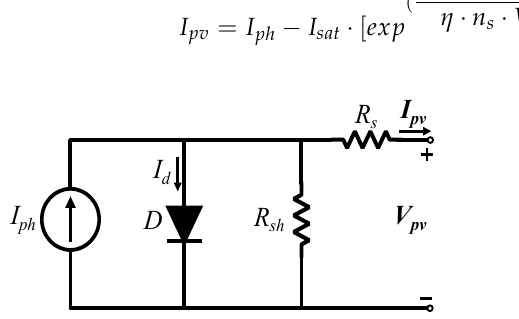
Figure 1. Single-diode model of PV